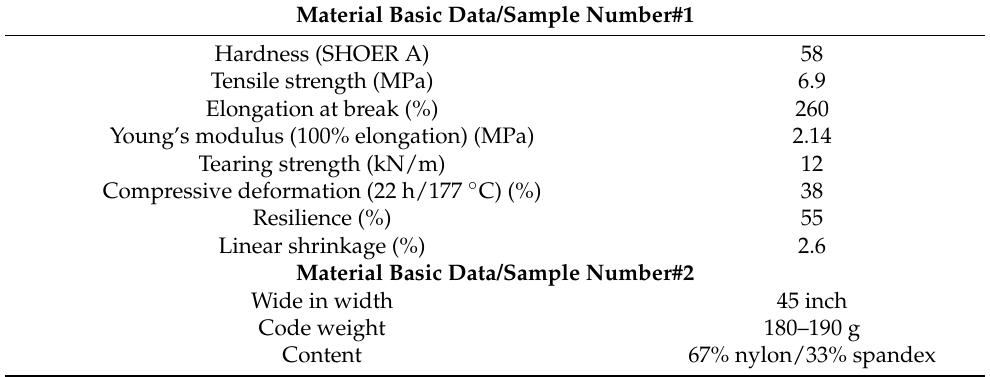
Table 2. Cooling vest